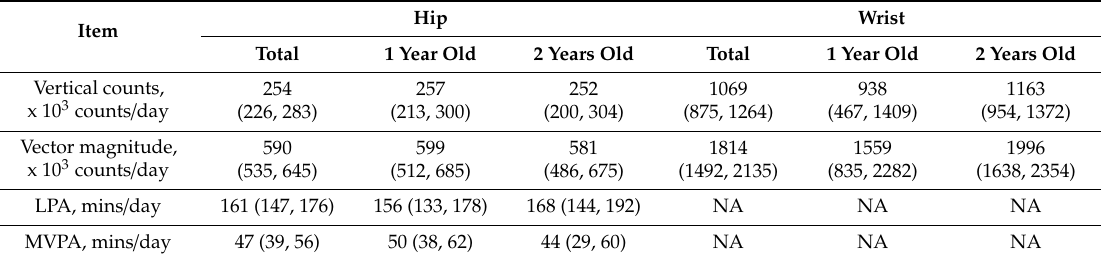
Table 2. Means and 95% confidence intervals of daily physical activity measures among